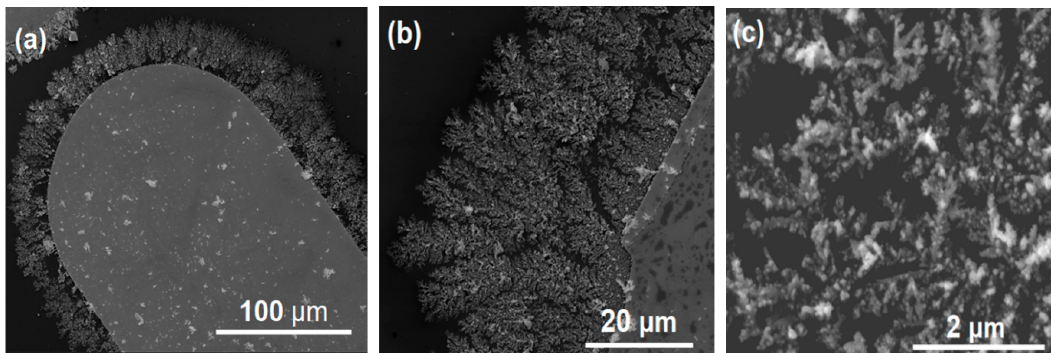
Figure 3. SEM images of dendritic silver nanoparticles structures at different magnifications. ( a ) Image of formed structures around the gold microelectrode. ( b ) Detail of the structure at the microelectrode edge. ( c ) Close-up showing individual nanoparticles participating in the structure. Nanoparticle assembly conditions, 10 Hz, 3 Vpp with 0.5 V DC bias.